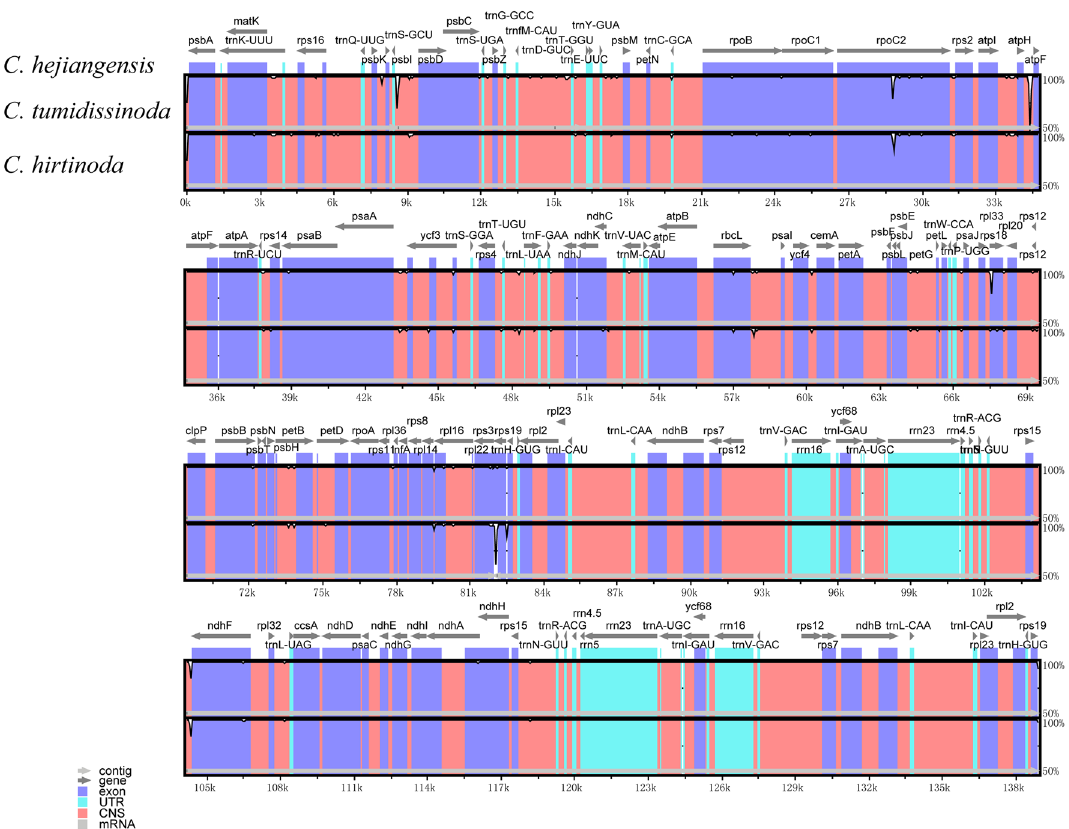
Figure 6. Visualization of genome alignment of three species chloroplast genome sequences using Chimonobambusa hejiangensis as reference. The vertical scale shows the percent of identity, ranging from 50 to 100%. The horizontal axis shows the coordinates within the cp genome. Those are some colors represents protein coding, intron, mRNA and conserved non-coding sequence, respectively.